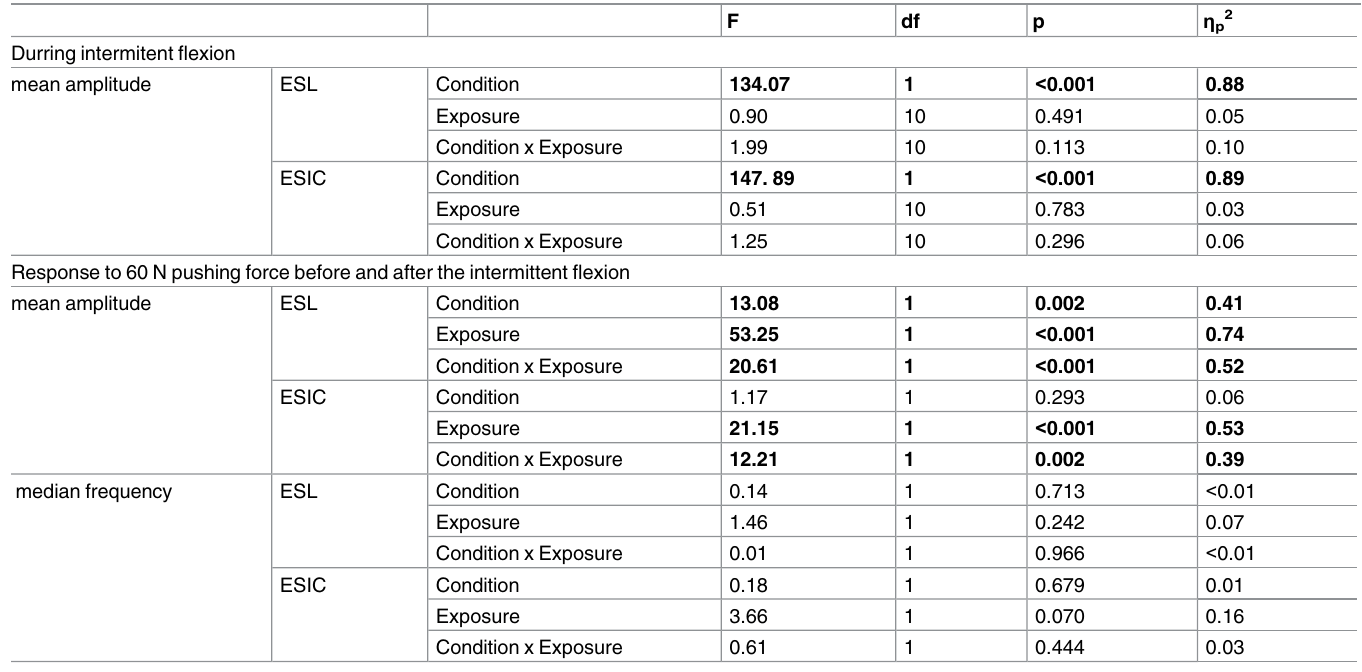
Table 2. Main and interaction effects results of the RMANOVA for supported and unsupported flexion on the EMG amplitudes.